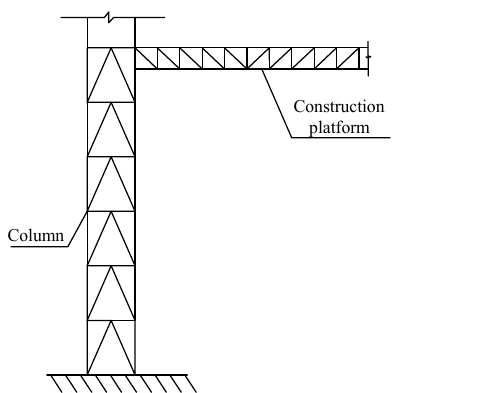
Figure 1. Schematic diagram of the construction platform (side view and top view).